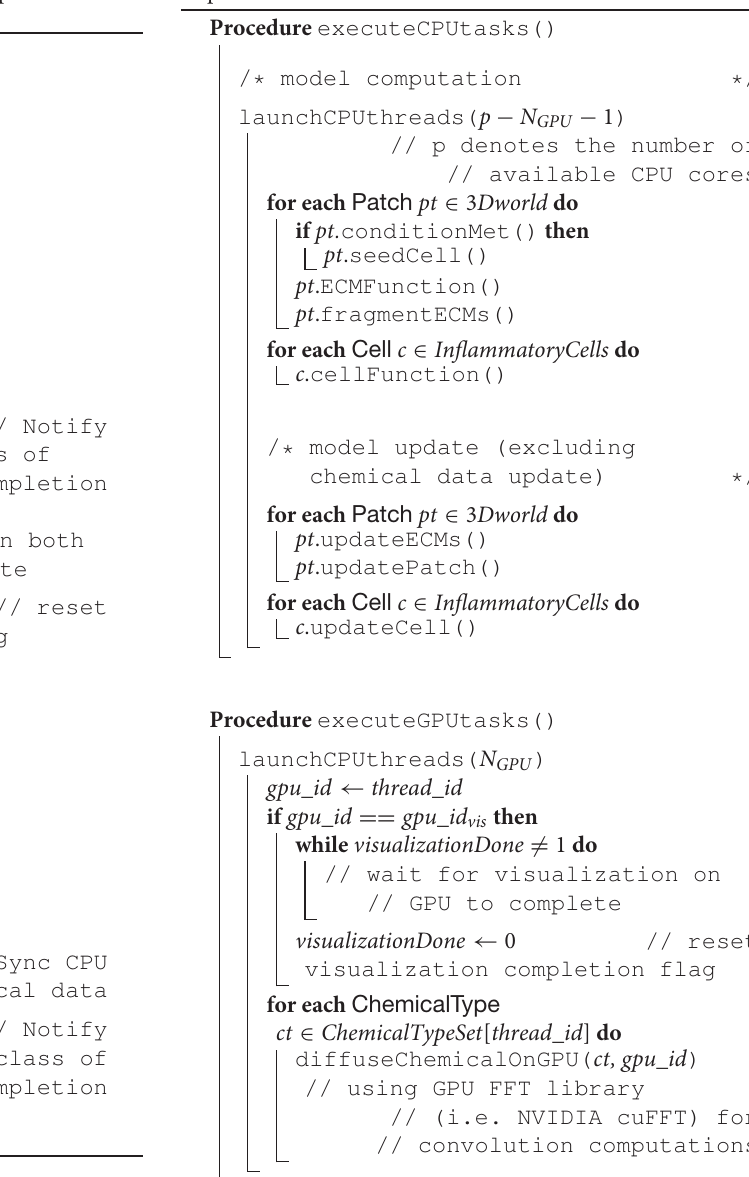
Algorithm 1: Pseudocode describing CPU-GPU scheduling related functions in Driver,